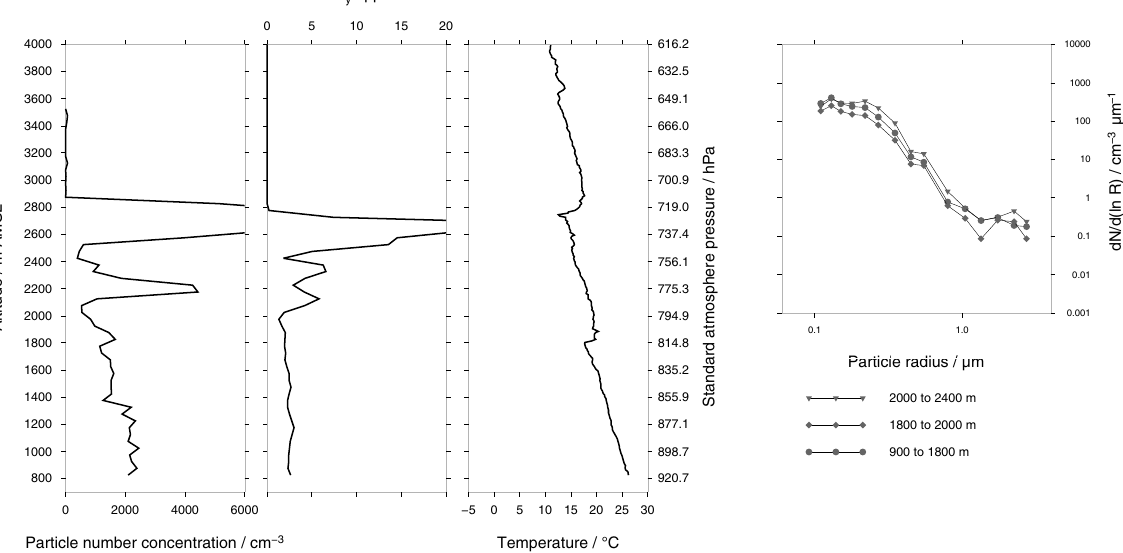
Figure 3. Vertical profiles of particle number concentration, in situ NO y , and temperature on 11 August 2007, over Nelspruit between 12:40 and 13:20UTC. The aircraft landed at Nelspruit, so the profile is measured down to the surface. Average particle size spectra for altitude intervals of interest are plotted. The elevated layer at ca. 2900–2500m is due to a large forest fire plume.